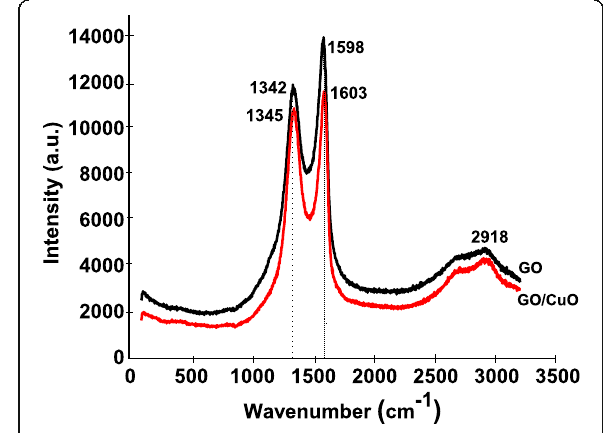
Fig. 5 FTIR of a GO and b GO/CuO Fig. 6 Raman Spectrum of a GO and b GO/CuO